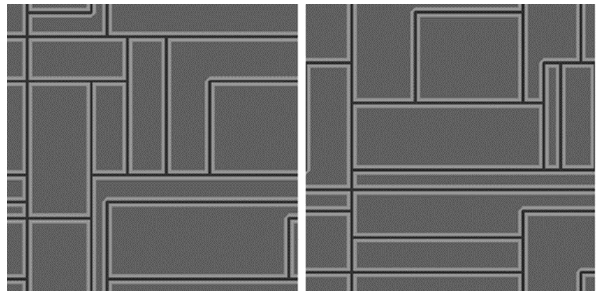
Figure 1. Two examples of artificial landscape structures gener- ated with 12 seeds. Agricultural fields (dark grey) are separated by grassy field margins (light grey) and surrounding hedgerows